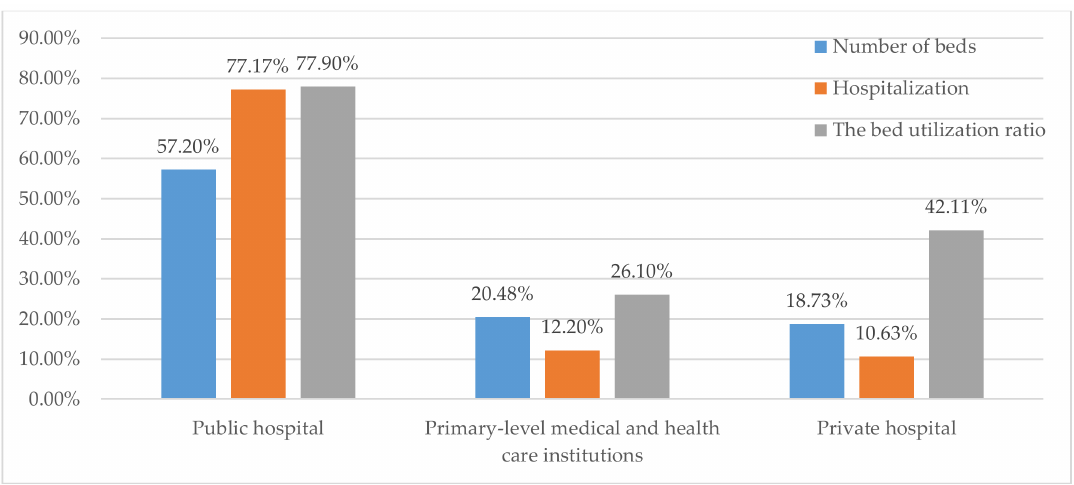
Figure 1. Distribution of medical resources in different types of hospital in Chengdu,